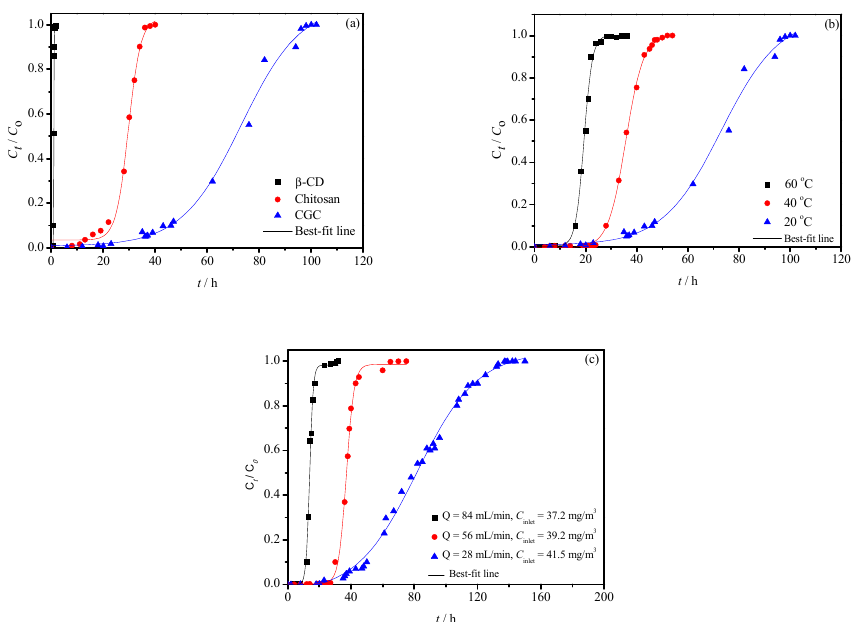
Figure 8. Experimental (scatters) and predicted (solid lines) breakthrough curves of HCHO adsorption: ( a ) Breakthrough curves for β -CD, chitosan, and CGC adsorbents at 20 ◦ C and feeding conditions of 28 mL/min and C inlet = 37.2 mg/m 3 ; ( b ) Breakthrough curves of CGC at various adsorption temperatures at 20 ◦ C, 40 ◦ C, and 60 ◦ C and feeding conditions of 28 mL/min and C inlet = 37.2 mg/m 3 ; and, ( c ) Breakthrough curves of HCHO at various feeding conditions of 28 mL/min with C inlet = 41.5 mg/m 3 , 56 mL/min with C inlet = 39.2 mg/m 3 , and 84 mL/min with C inlet = 37.2 mg/m 3 , respectively. Table 6. Breakthrough curve characteristic parameters under different operating conditions. Adsorbent